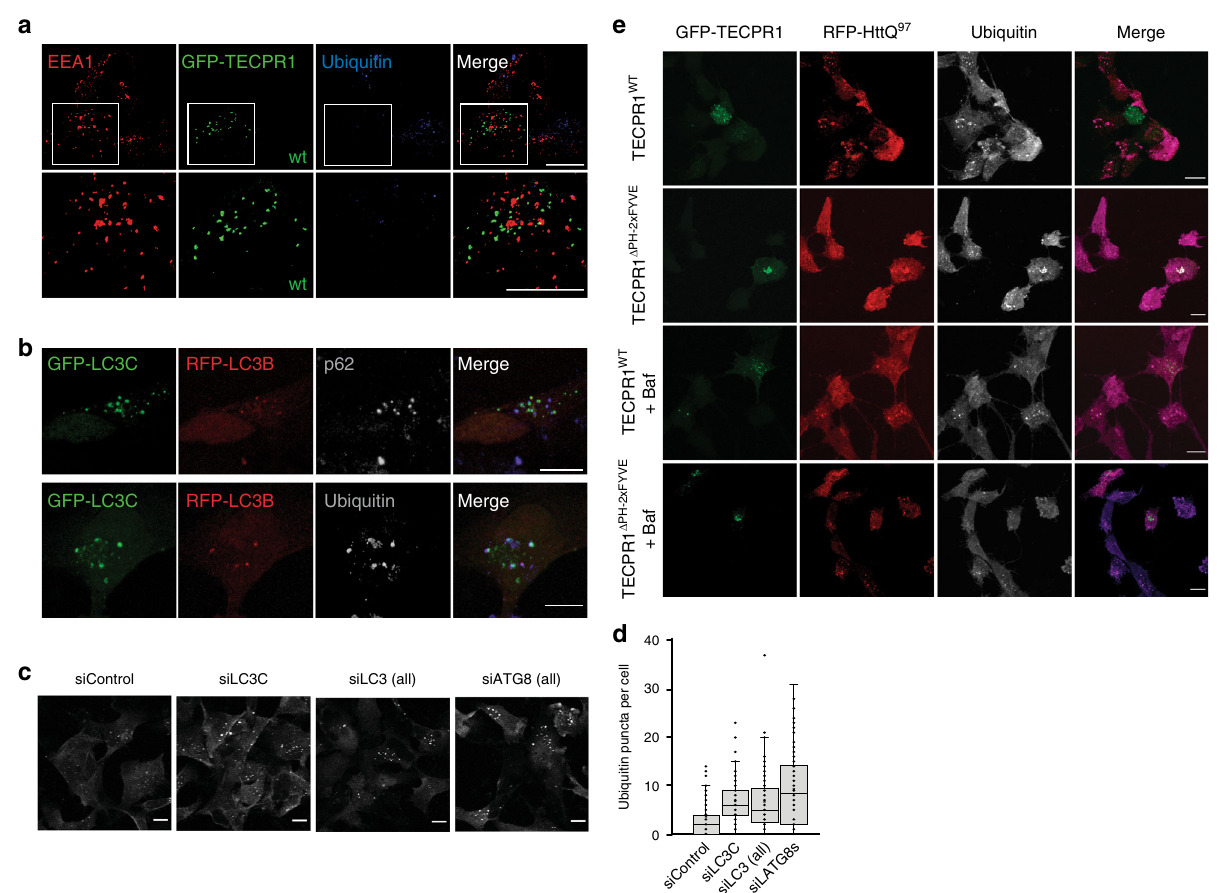
Fig. 7 TECPR1 promotes aggregate clearance in neural cells. a Confocal images of neural stem cells expressing GFP-TECPR1 that were immunostained for EEA1 and Ubiquitin. The lower panel shows a magni fi cation of the area that is indicated in the upper panel. Scale bar = 10 µ m. b Confocal images of NSCs coexpressing GFP-LC3C and RFP-LC3B, costained for p62 or ubiquitin as indicated. Scale bar = 10 µ m. c Confocal images of NSCs that were treated with siRNAs against ATG8 proteins as indicated and immunostained for ubiquitin. Scale bars, 10 µ m. d Quanti fi cation of Ub puncta per cells from data corresponding to representative images as shown in c from cells of randomly chosen fi eld of views ( n = 70 cells pooled from four independent experiments). Box plots represent the fi rst (25%) and third (75%) quartiles, respectively. The center line represents the median, whiskers the standard deviation and minima and maxima are available from the Source Data fi le. e Confocal images of NSCs expressing RFP-HttQ 97 and GFP-TECPR1 or GFP- TECPR1 Δ PH2xFYVE , immunostained for ubiquitin were treated with the lysosomal inhibitor Ba fi lomycin A1 (Baf) as indicated. Note that for merged images, ubiquitin is shown in the blue channel instead of gray. Scale bar = 10 µ m. See also Supplementary Movie 6. Source data are provided as a Source Data fi